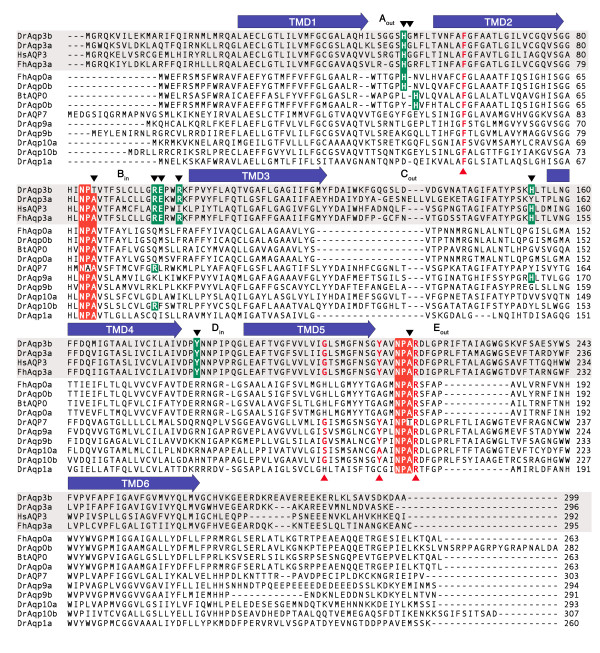
Amino acid sequence alignment of zebrafish GLPs, Aqp1a and Aqp0a with mammalian and teleost orthologs. Amino acid sequence alignment of representative GLPs and water-selective aquaporins of teleosts and mammals: Danio rerio Aqp0a (DrAqp0a; FJ666326), -0b (FJ655389), -3a (EU341833), -3b (EU341832), -7 (FJ655385), -9a (FJ655387), -9b (EU341835), -10a (FJ655388), -10b (EU341836), and -1a (AY626937), Fundulus heteroclitus Aqp0a (FhAqp0; AF191906) and -3a (ACI49539), Homo sapiens AQP3 (HsAQP3; BC013566), and Bos taurus AQP0 (BtAQP0; NM_173937). Predicted transmembrane domains (TMD1-6) of DrAqp3b are annotated by blue arrows, and external (out) and internal (in) loops are indicated. The two NPA motifs are shaded in red, whereas the four residues forming the aromatic/arginine (ar/R) constriction in zebrafish GLPs (Phe, Gly/Ser, Tyr/Ala, and Arg) [48] are pointed by red arrowheads. Potential residues involved in pH sensitivity in AQP0 and -3 orthologs are shaded in green, and mutated residues in DrAqp3b are indicated by black arrowheads.